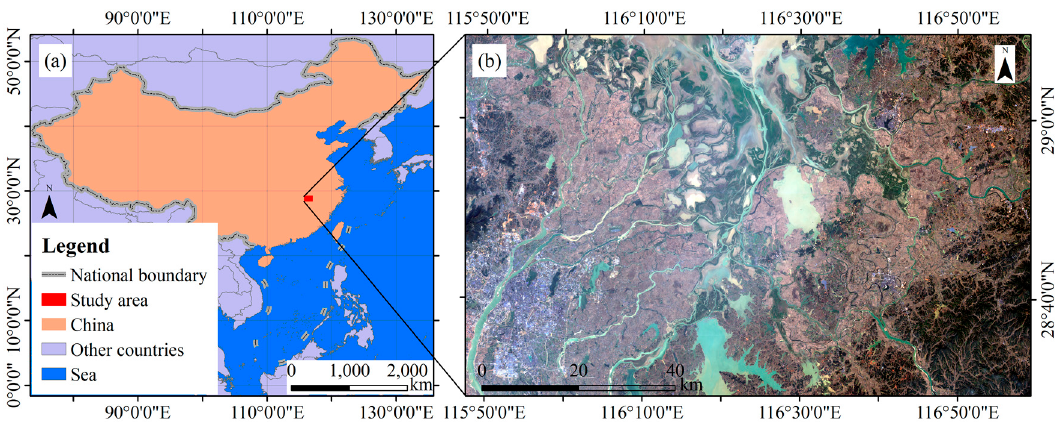
Figure 1. Location of study area: ( a ) The red rectangle indicates the study area (74 km × 120 km) in southeast China; and ( b ) a Landsat-8 true-color image (RGB: 432) of the study area taken on 16 December 2016.